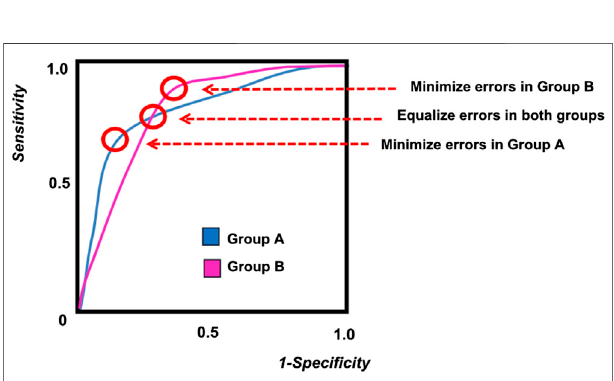
FIGURE 2 | A sample ROC curve for multiple groups, showing different possible operating points for the